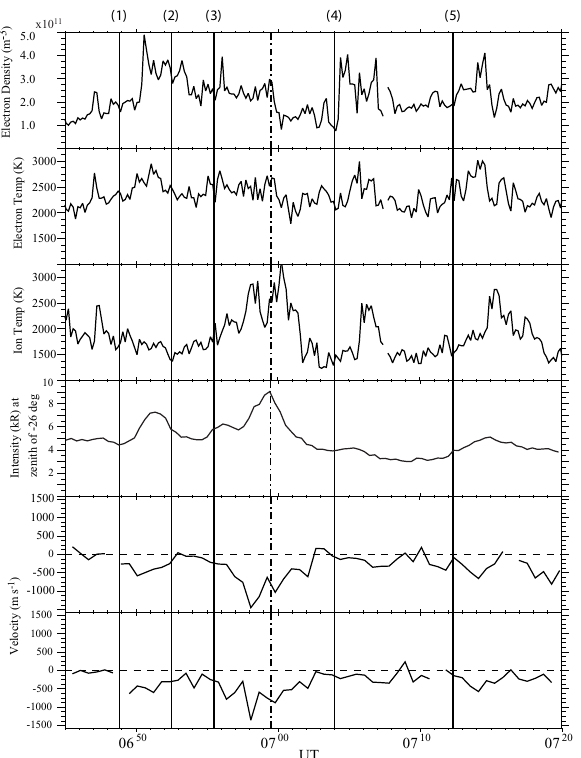
Fig. 7 Fig. 7. The top three panels show the electron density, electron tem-